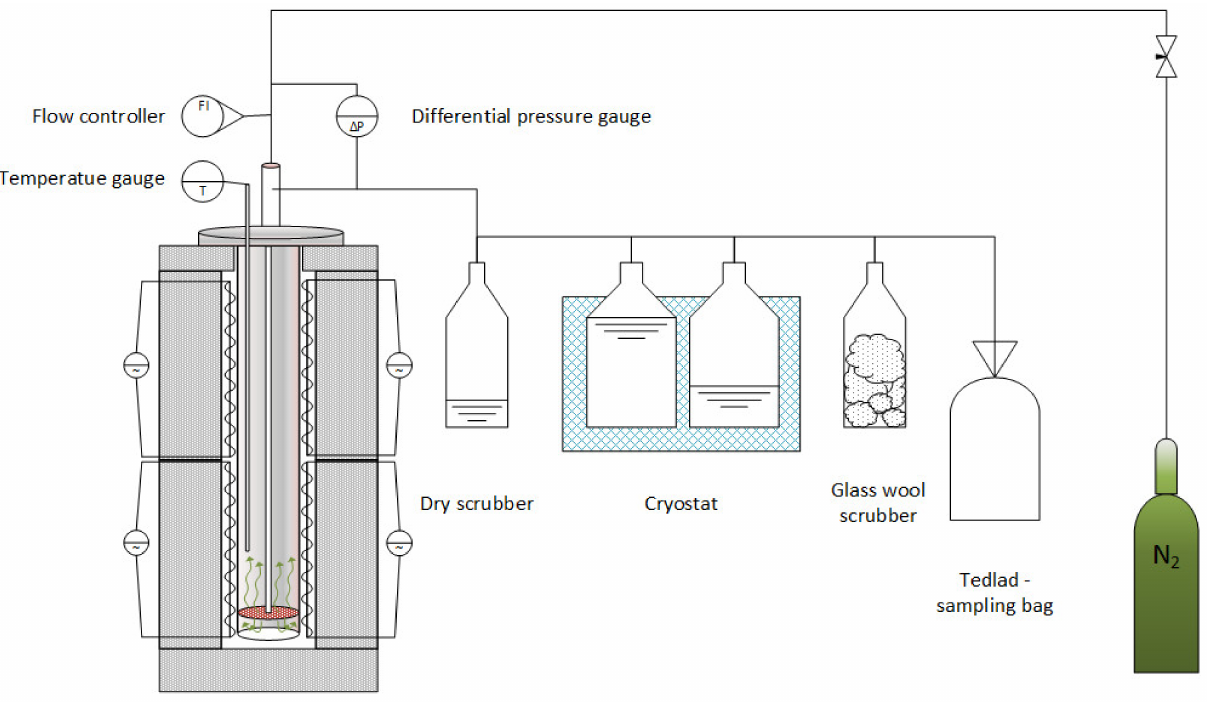
Figure 1. Test setup for co-pyrolysis of biomass and plastic blends in a fixed-bed